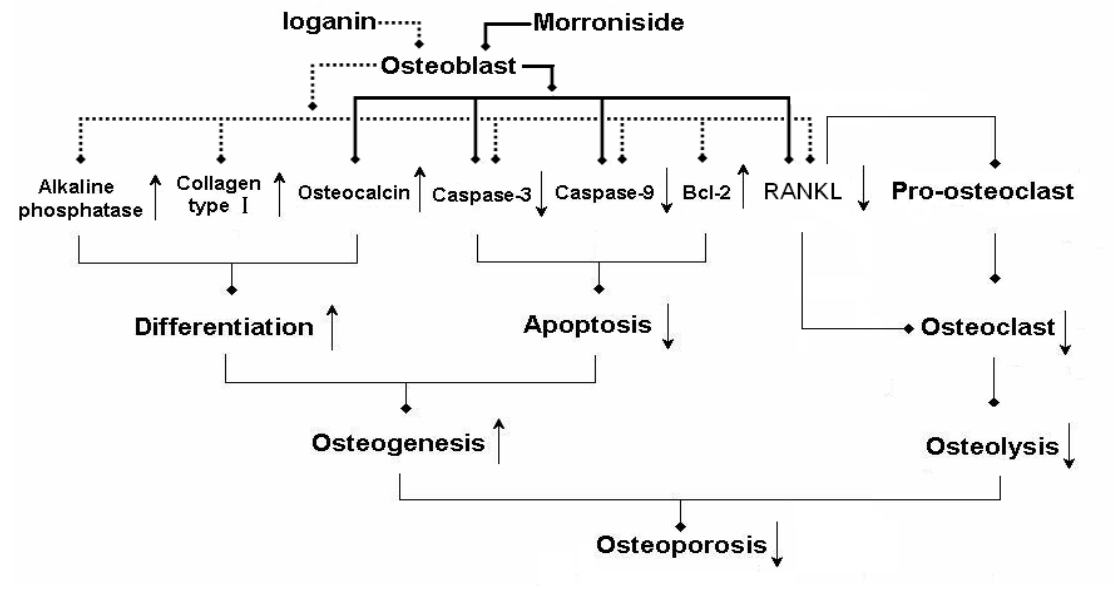
Figure 4. The molecular mechanism of morroniside and loganin on treating